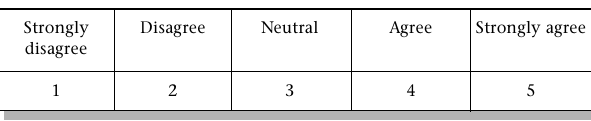
Figure 3: Example of a Likert response scale where all categories are anchored